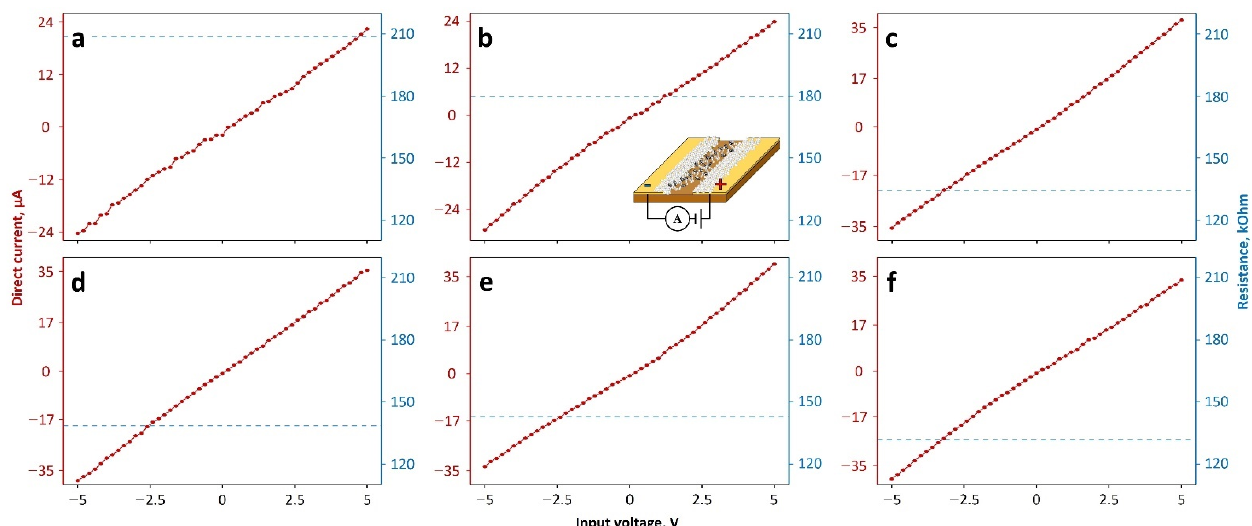
Figure 4. I-V characteristics of exemplary sensor segments of ZnO layer electrochemically grown at different deposition time t : ( a ) t = 400 s; ( b ) t = 550 s; ( c ) t = 700 s; ( d ) t = 850 s; ( e ) t = 1000 s; ( f ) t = 1150 s. The I–Vs were recorded under dry air conditions at a temperature of 150 °C. The right Y-axis in the plots yields the resistance values extracted from the I-Vs. The inset at ( b ) shows the electrical scheme to measure I–Vs over the segment at the chip.